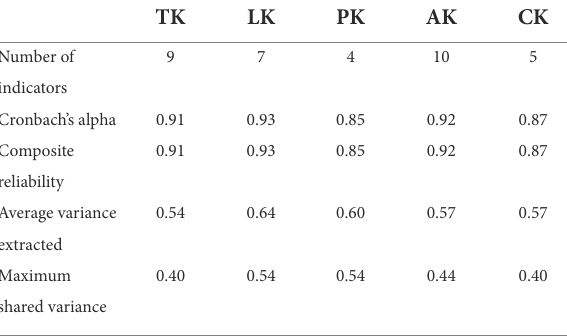
TABLE 2 The test results of the reliability and validity of the TLPACK